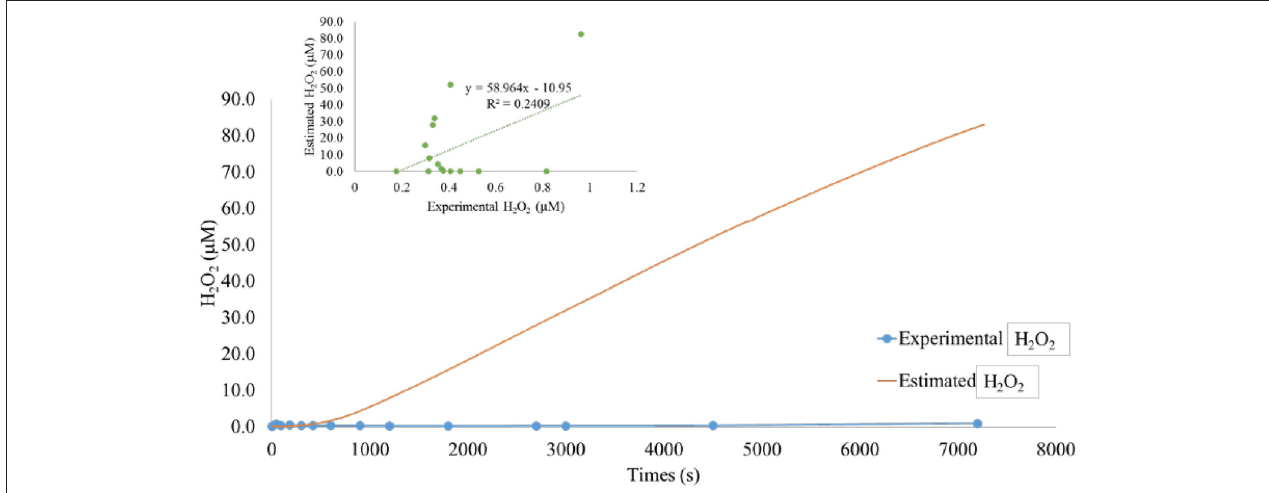
FIGURE 7 | Modeled vs. predicted hydrogen peroxide, pH 7.00. Modeled superoxide was used to predict hydrogen peroxide observed in sediment suspensions. In marsh sediment suspensions at pH 7.00 the model over predicted hydrogen peroxide by approximately a factor of 100, indicating the presence of an unknown hydrogen peroxide sink. Correlation between model and data shown in the